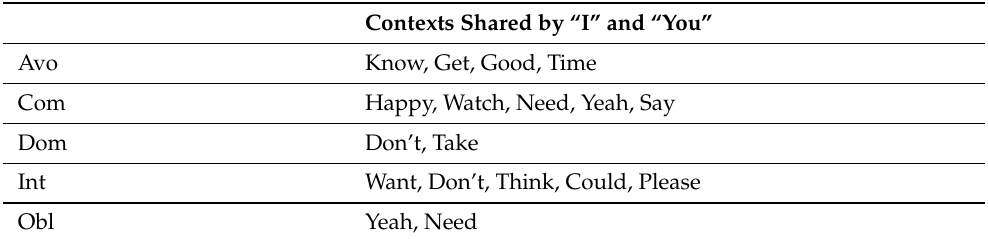
Table 9. Words that are used in shared similar contexts as the pronouns “You” and “I” across the